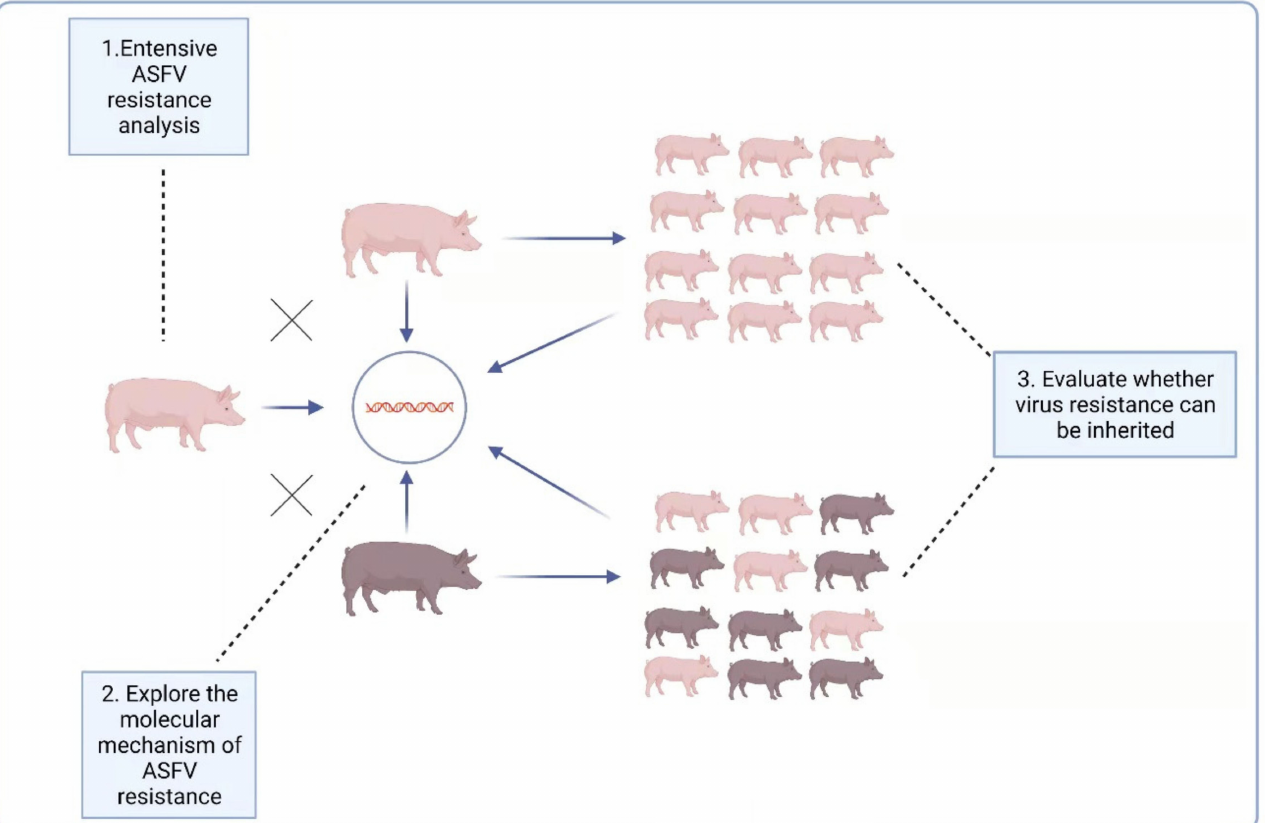
Figure 2. Three levels of LS-2 ASFV-resistance characteristics that need to be further